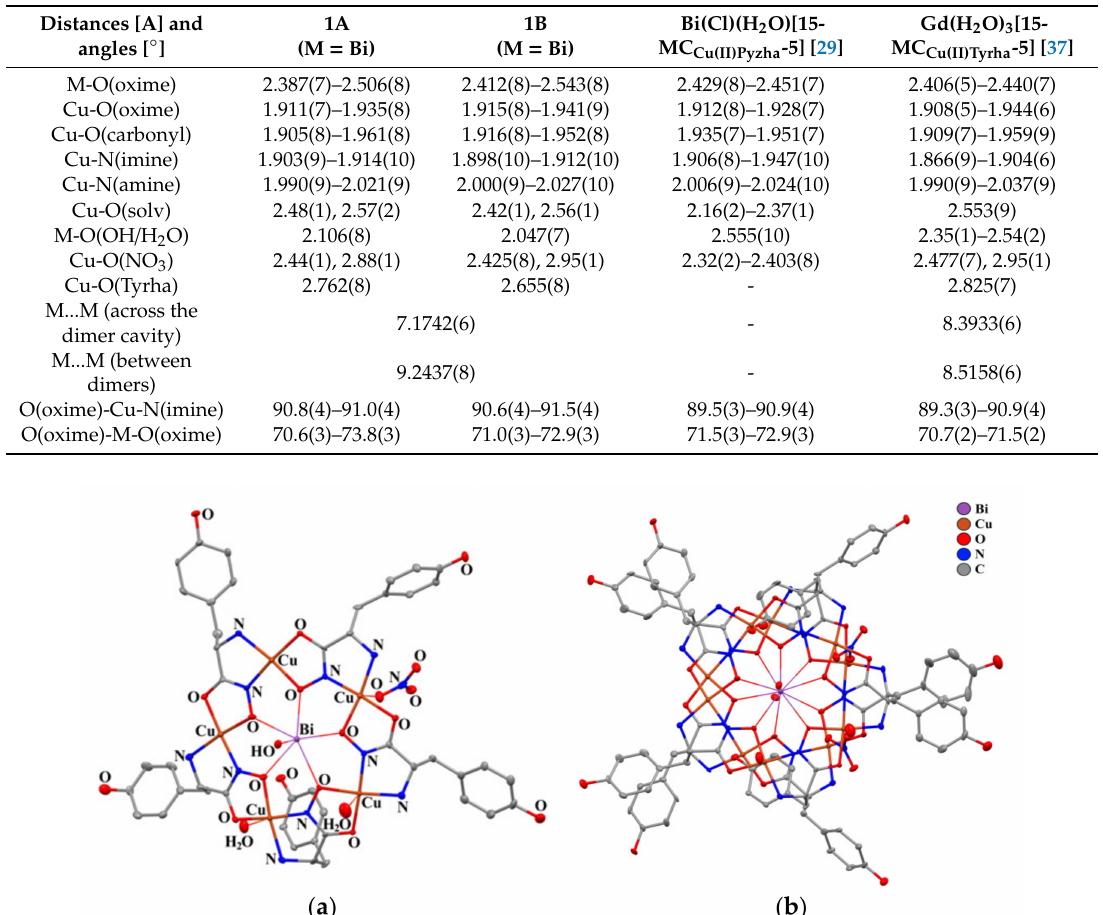
1. Comparison of X-ray structural parameters of complex 1 with